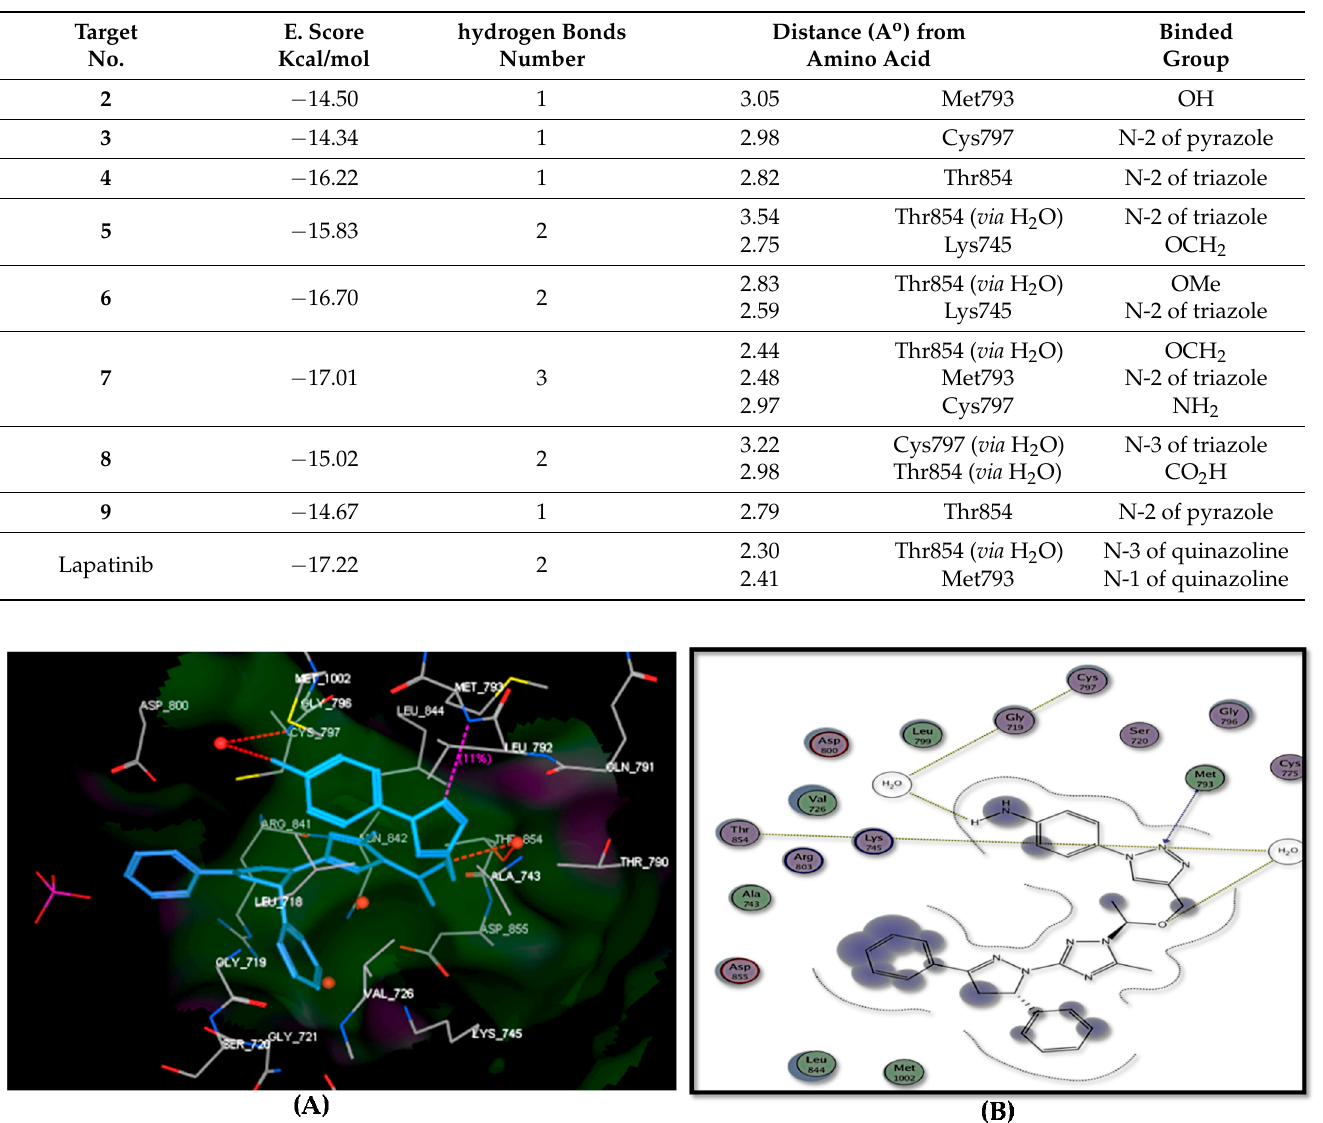
Table 4. Docking data for compounds 2 – 9 within EGFR enzyme (PDB: 1XKK).